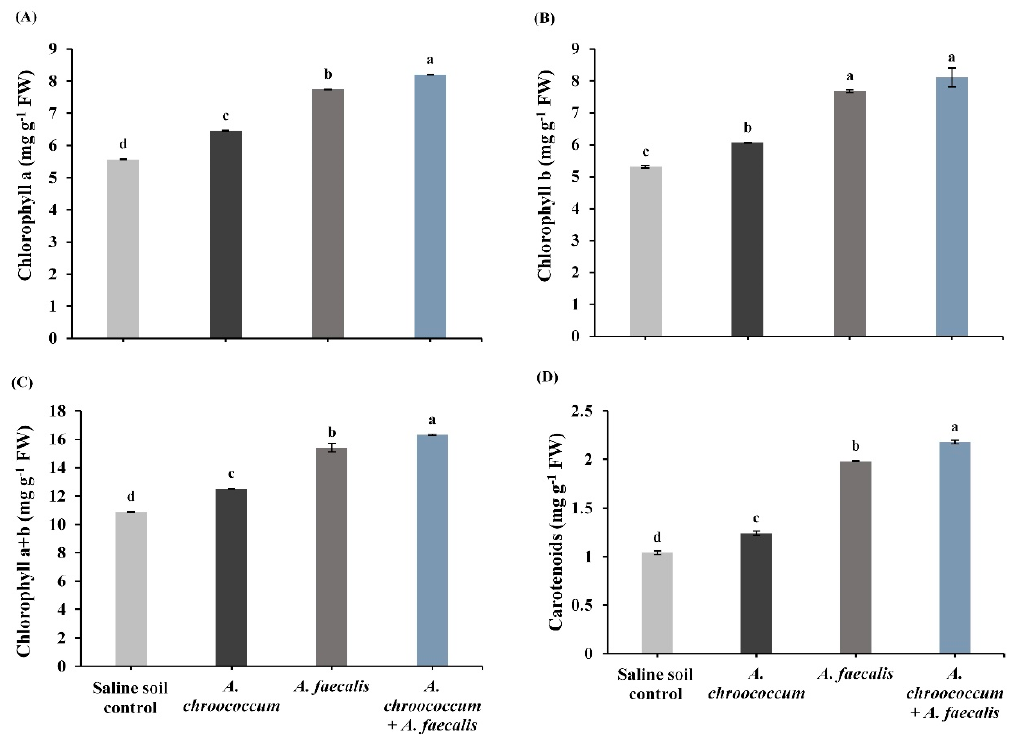
Figure 2. ( A ) Chlorophyll a; ( B ) chlorophyll b; ( C ) chlorophyll a + b; and ( D ) carotenoids’ content in canola plant fresh leaves inoculated with Azotobacter chroococcum, Alcaligenes faecalis, and their co-inoculation under salinity-stress conditions. Bars show means of three independent replications (n = 3) ± standard error. Means with the same letter are not significantly different at p < 0.05. FW: fresh weight.